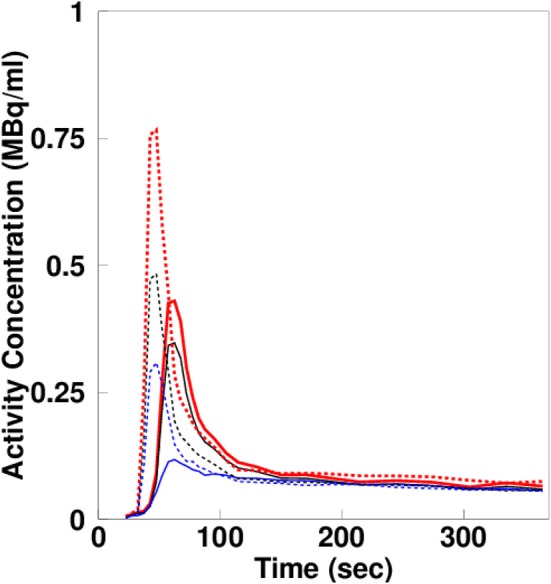
Estimated left and right ventricle blood curves, extracted left and right ventricle curves, and left and right myocardial activity curves.